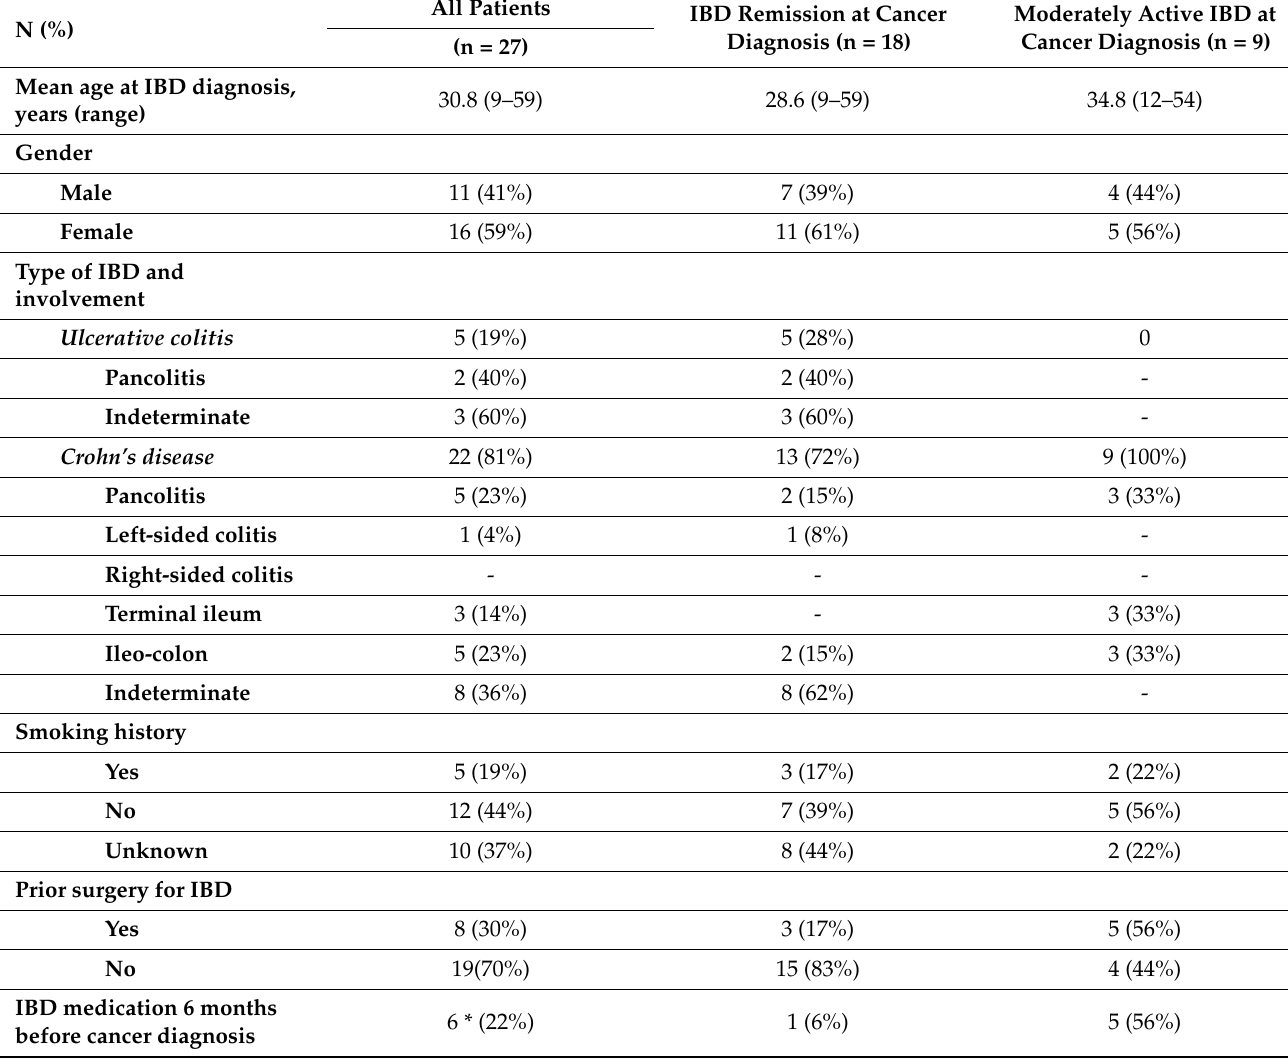
Table 1. Baseline characteristics. IBD: inflammatory bowel disease; * IBD medication 6 months before cancer diagnosis consisted of corticosteroids in five patients and infliximab in one